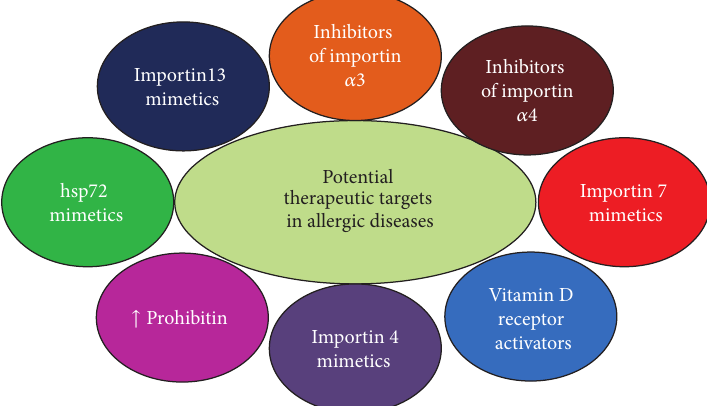
Figure 5: Schematic diagram showing various target sites for intervention in allergic diseases: there are many sites in the importin-exportin system in inflammatory cells involved in allergic diseases. Detailed knowledge on the involvement and role of specific importin molecule and/or the synthesis of mimetics/activators of endogenous inhibitors would help in the development of better therapeutic approaches in allergic